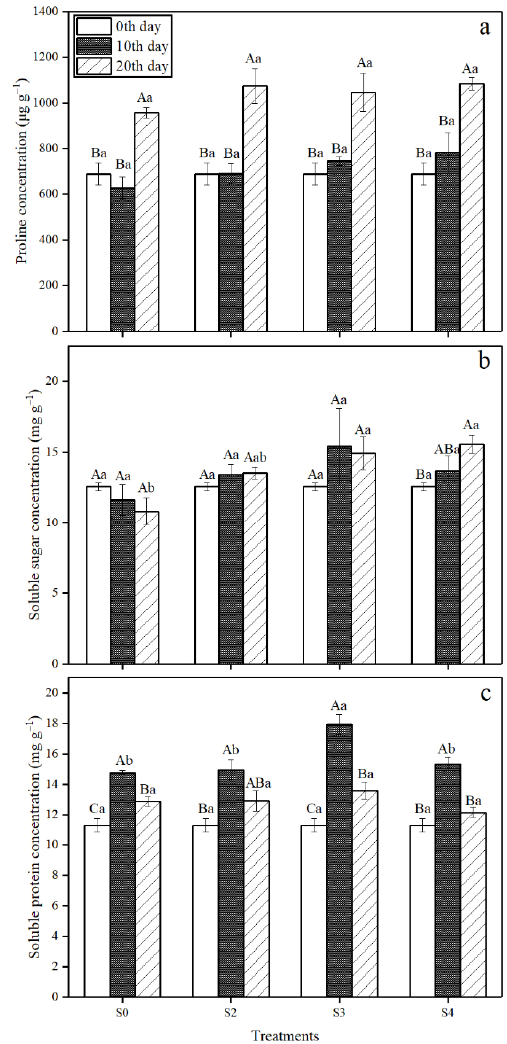
Figure 4. Effects of salinity stress on ( a ) proline concentration, ( b ) soluble sugar concentration, and ( c ) soluble protein concentration in C. elegans seedlings. S0, S2, S3, and S4 indicate control, 0.2%, 0.3%, and 0.4% salt concentration treatments, respectively. Columns are the mean ± standard error. Lowercase letters denote statistical results among different treatments at the same sampling time, and uppercase letters denote statistical results among different sampling times for the same treatment. The same letters are not different by the Duncan’s new multiple range test at 5%